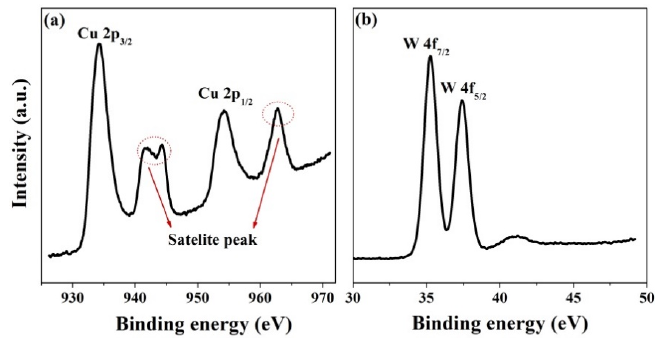
Figure A1. ( a ) Cu 2p spectrum and ( b ) W 4f XPS spectrum of the CuO / WO 3 (1:1) samples.